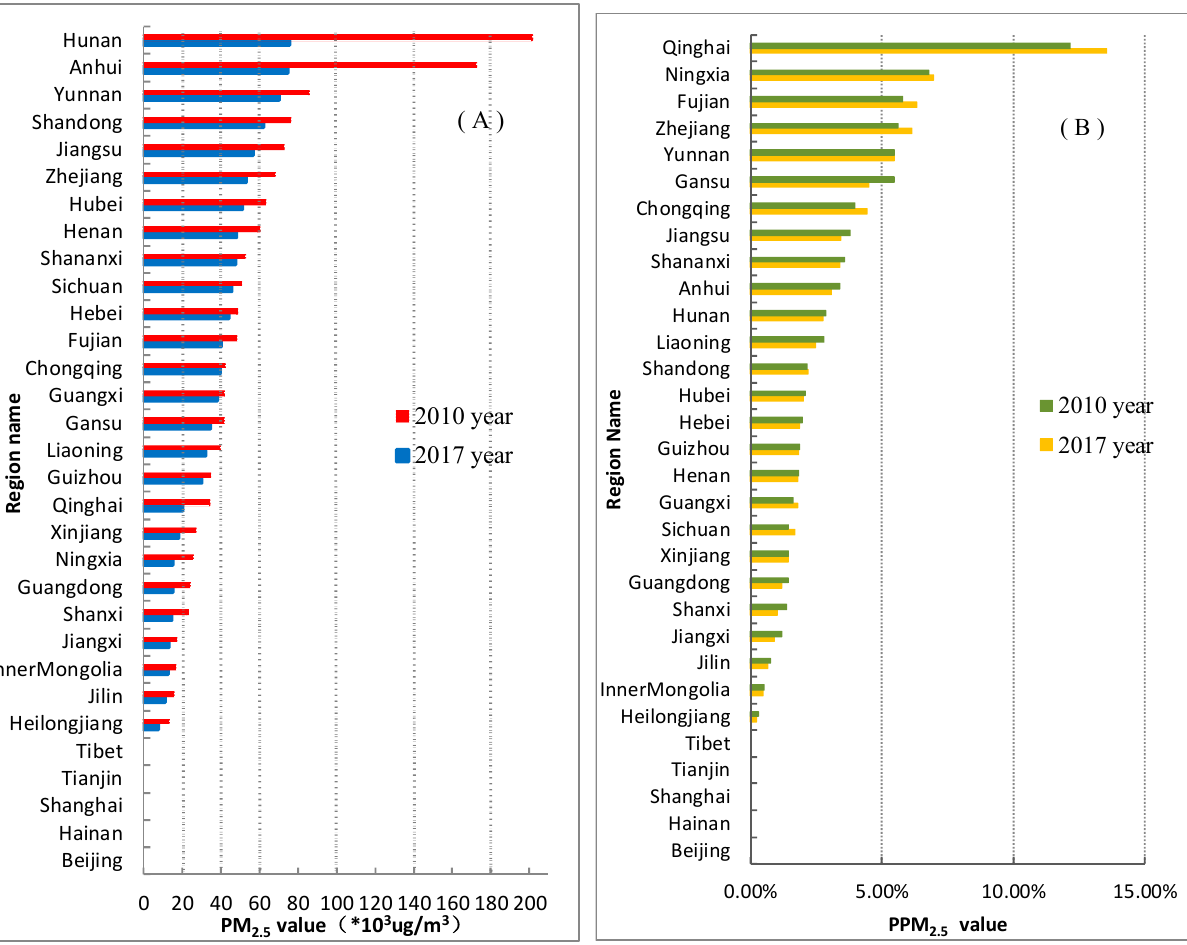
Figure 4. The annual PM 2.5Cement value ( A ) and PPM 2.5Cement value ( B ) of each province in the study area in 2010 and 2017.